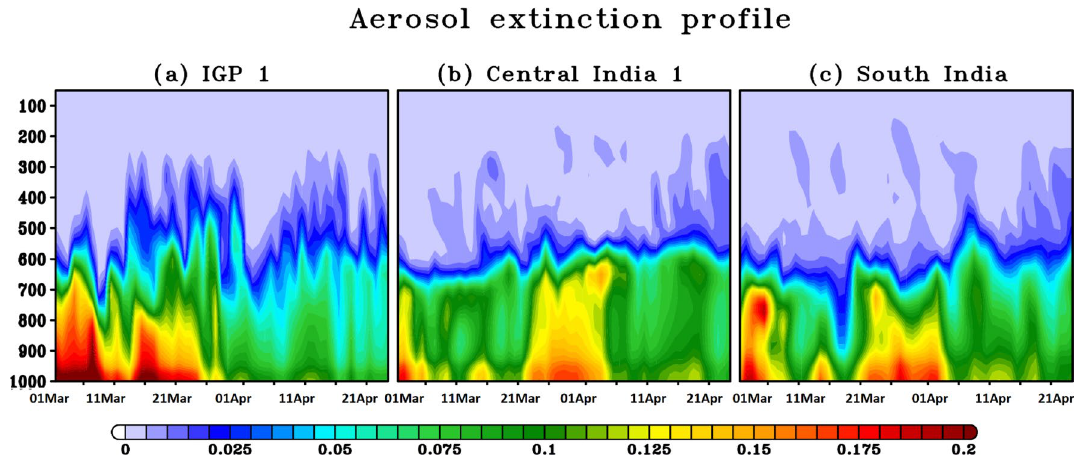
Figure 5. Vertical distribution of the aerosol extinction coefficient observed over ( a ) the IGP region, ( b ) Central India, and ( c ) South India during PLD and DLD periods. The figures are plotted using GrADS V2.2.1 software (http:// cola. gmu. edu/